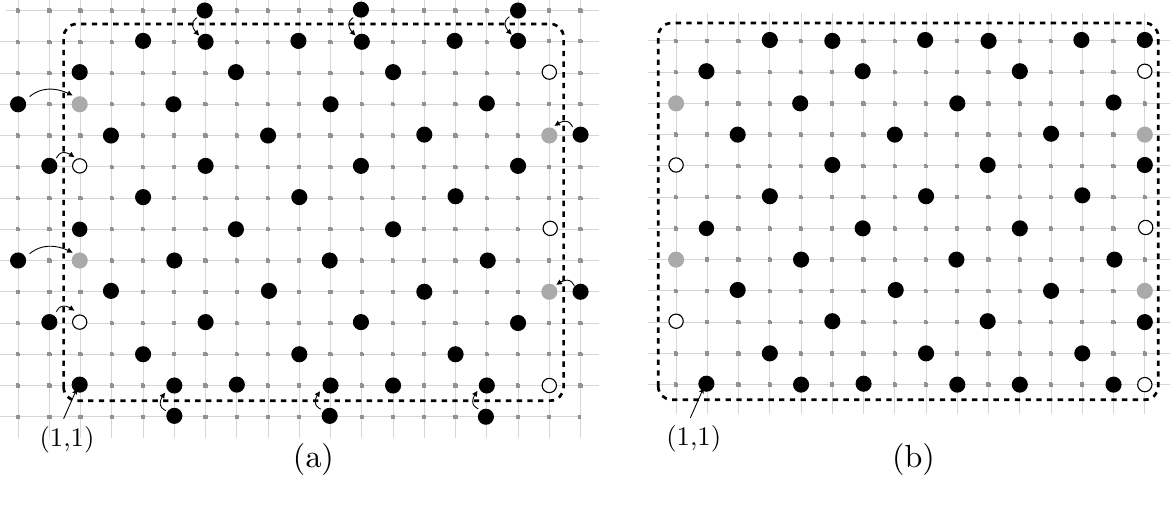
Figure 11: Examples of placing core (black), white and grey guards in P Two vertices u, v are said to be horizontally adjacent if u is a neighbor to the left or right of v , in the usual drawing of P P . By the placement of guards, no black, white or grey m (cid:3) n guards are horizontally adjacent, except perhaps at the corner vertices. We leave the careful examination of the corners until the end of the